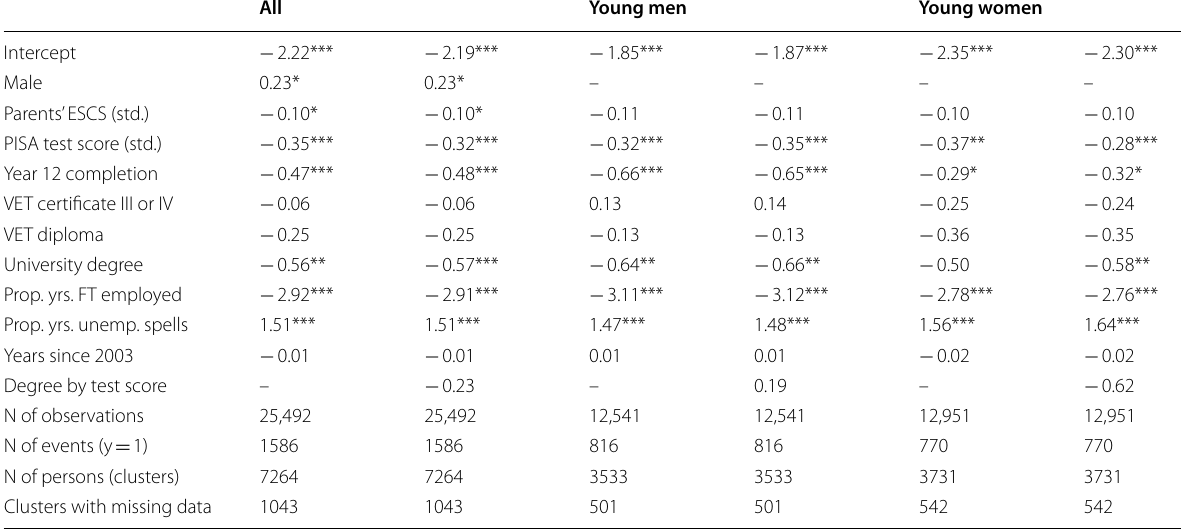
Logit regression coefficients from repeated design analyses. Contrast unemployed vs employed. Full-time study observations excluded. Weighted for sample selection and attrition. See Table 1 for abbreviations